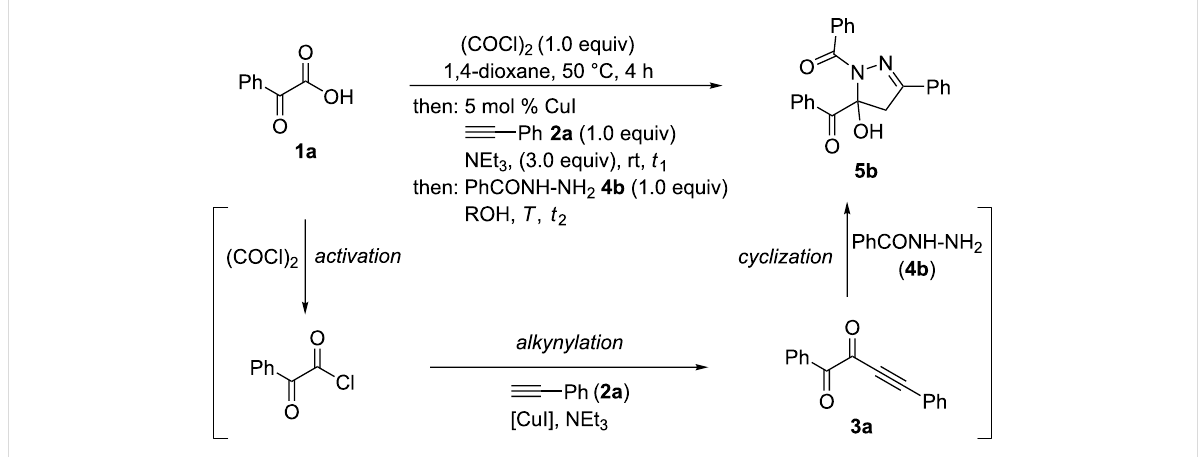
Scheme 4: Model reaction for optimizing the activation–alkynylation–cyclization synthesis of 1,5-diacyl-5-hydroxypyrazoline 5b .